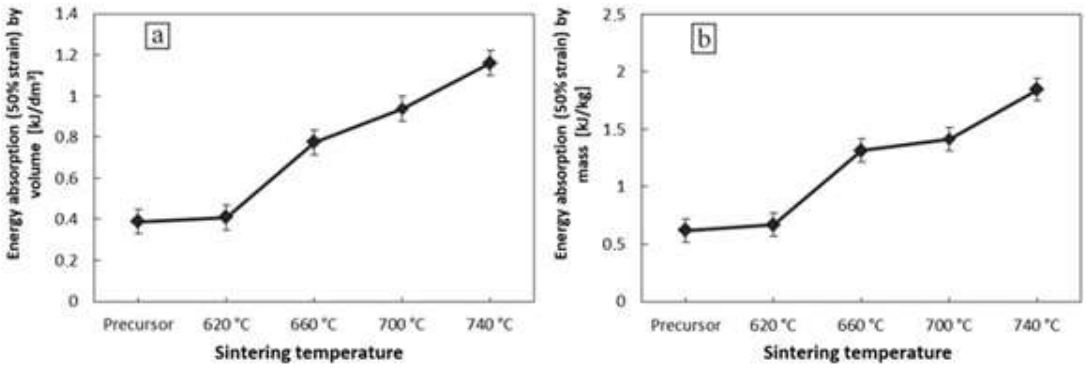
Figure 8. Energy absorption for 50% strain by volume ( a ) and by mass ( b ) for Al-foams with various sintering temperatures.